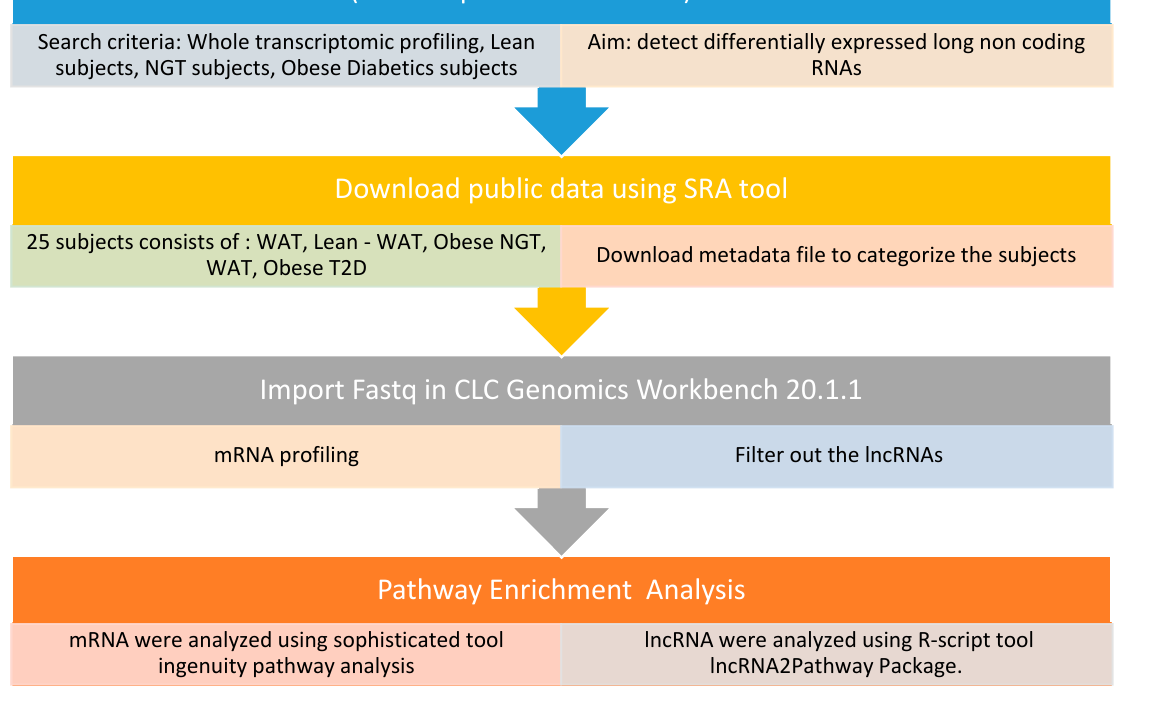
Figure 10. Bioinformatics analysis workflow from the retrieval of the public data of GEO to the analysis of dysregulated/affected pathways.